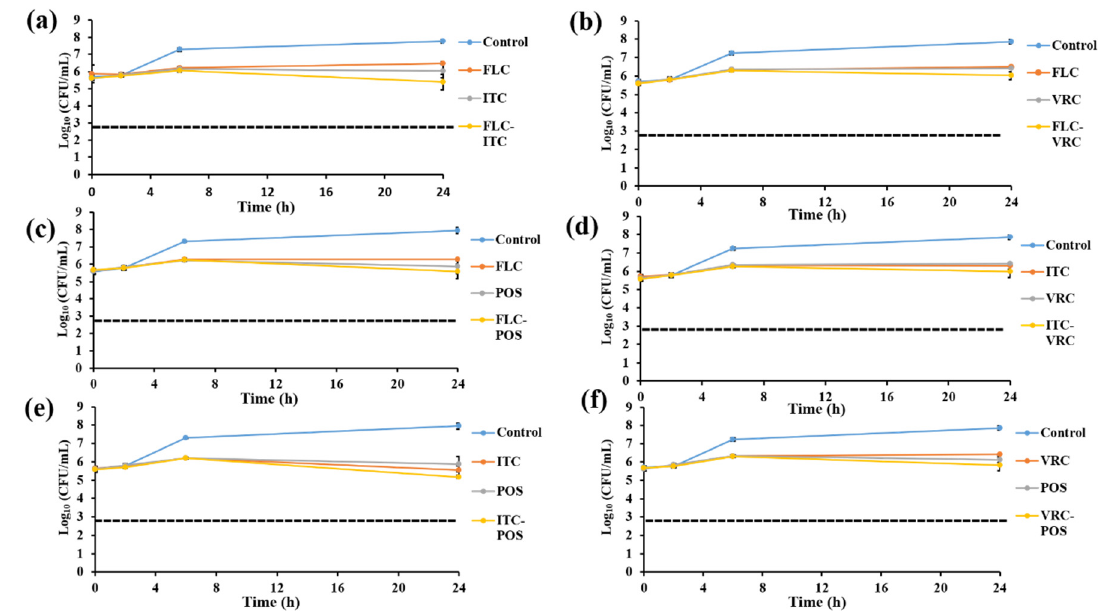
Figure 3. In vitro activities of azoles alone and in combinations including FLC-ITC 25–4 µ g/mL ( a ), FLC-VRC 25–1 µ g/mL; ( b ), FLC-POS 25–4 µ g/mL; ( c ), ITC-VRC 4–1 µ g/mL; ( d ), ITC-POS 4–4 µ g/mL; ( e ), and VRC-POS 1–4 µ g/mL; ( f ) against C. glabrata IFM60089 as determined by the time-killing assay. The detection limit was 20 CFU/mL. Dashed lines represent a >99.9% growth reduction compared with the initial inoculum size for determination of fungicidal activity. All azole combinations showed indifferent interactions. Each data point represents the means ± standard deviation of results from two independent experiments.